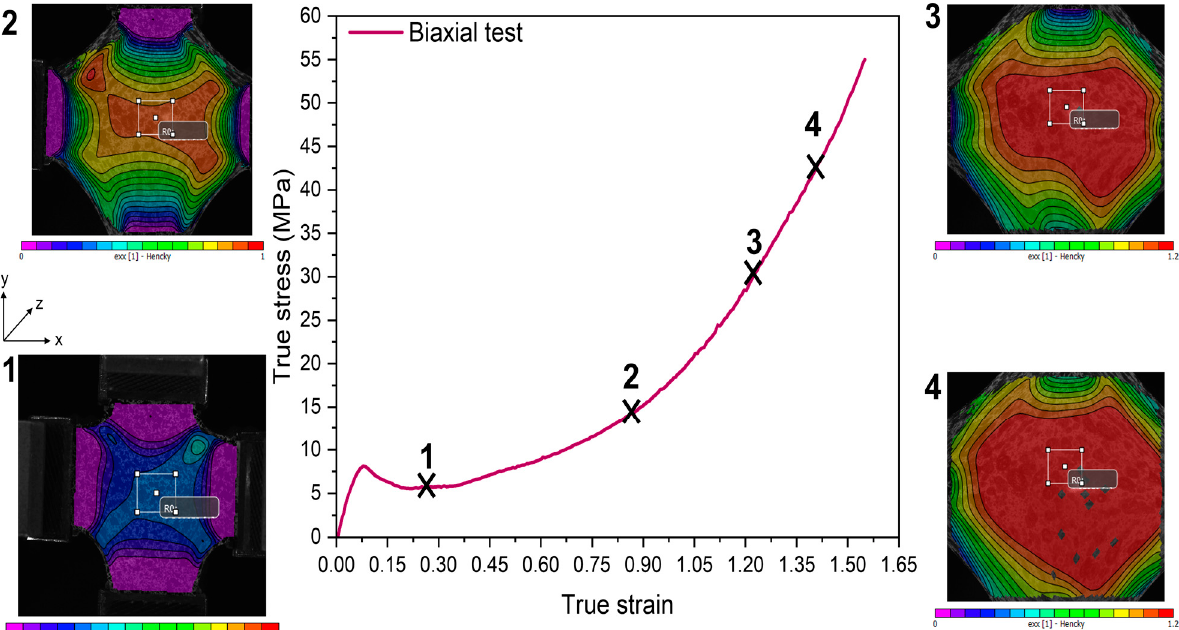
Figure 3. True stress strain curve of PEF upon equilibrated and balanced biaxial stretching, at a temperature of 105 °C, a strain rate of 0.05 s − 1 (equivalent strain rate of 0.02 s − 1 ) and until stretching ratios of 4.76 × 4.22. The 2D strain fields for different positions along the curve have been added.